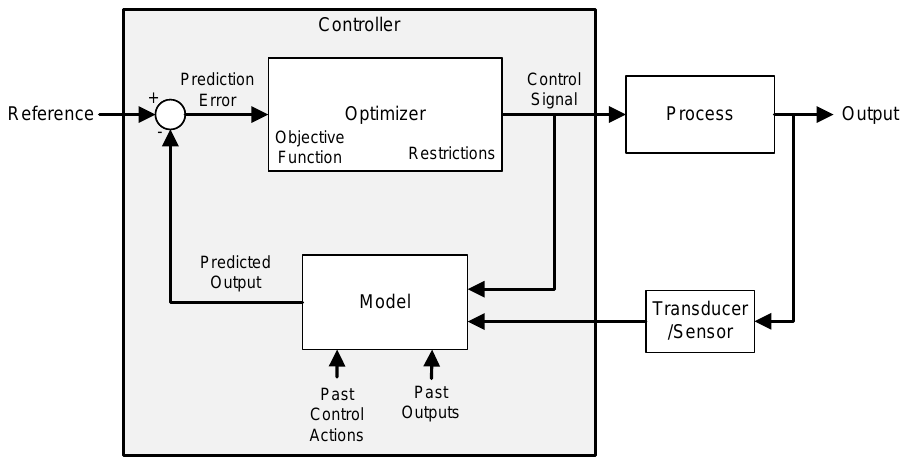
Figure 1. Flowchart of the model-based predictive control